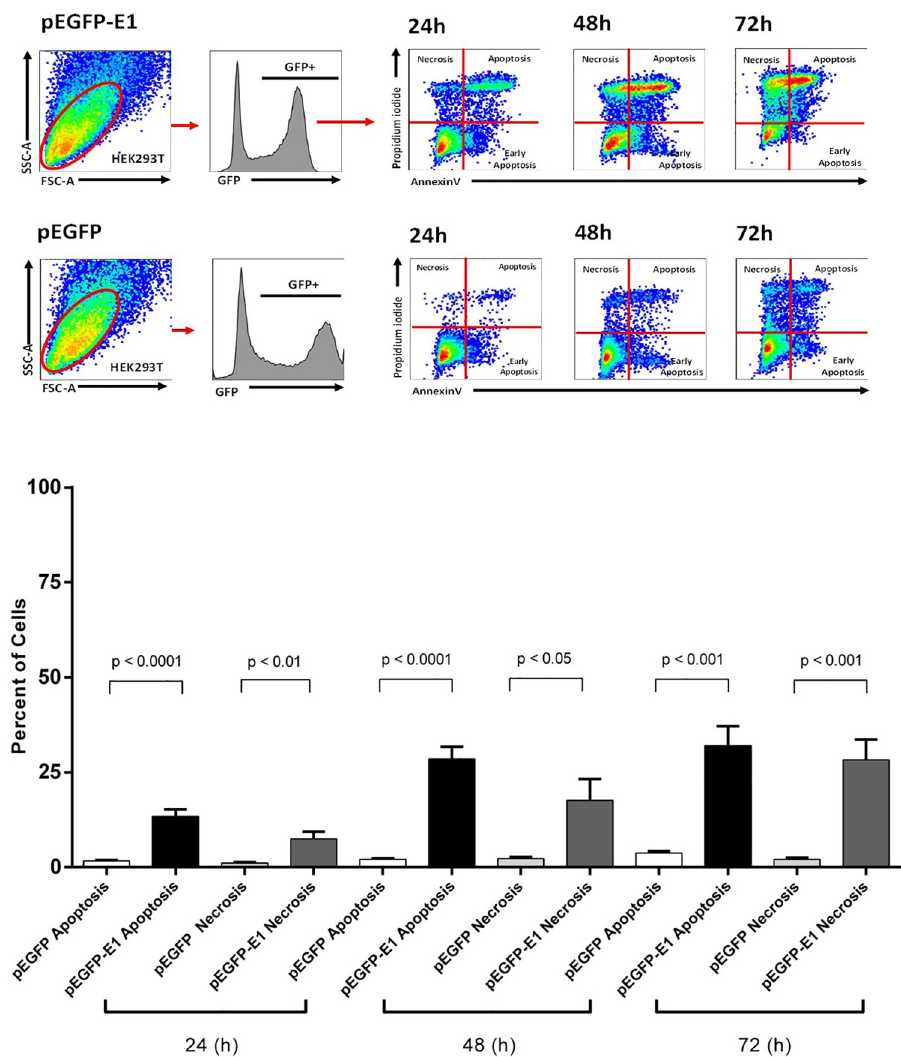
Fig 7. HPV16 E1 induces both apoptosis and necrosis. HEK 293 T cells were transfected with either pEGFP or pEGFP-E1. Apoptosis (annexin V staining) and necrosis (propidium iodide staining) were measured by flow cytometry. A: GFP+ HEK293T cell populations were gated. The frequencies of necrosis cells were identified as annexinV-PI+, apoptosis cells were identified as annexinV+PI+ and early apoptosis cells were identified as annexinV +PI-. B: Mean percentage of apoptosis and necrosis from 3 independent experiments were shown with statistically significance at p -value <